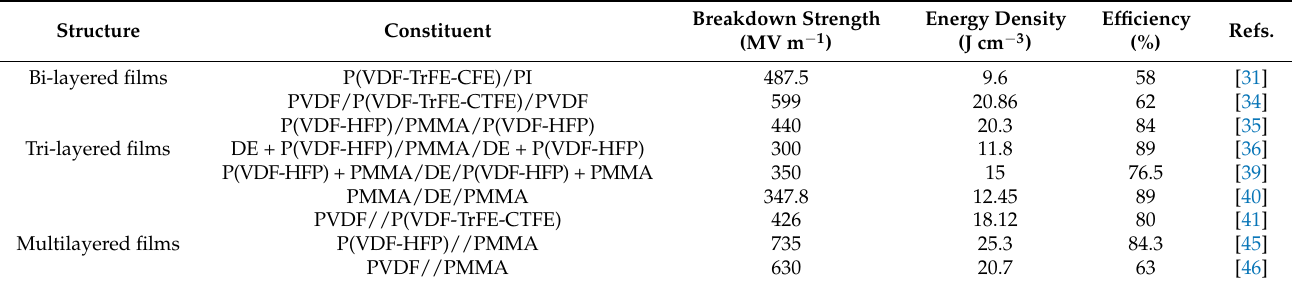
Table 2. Energy storage properties of the multilayered hierarchical polymer